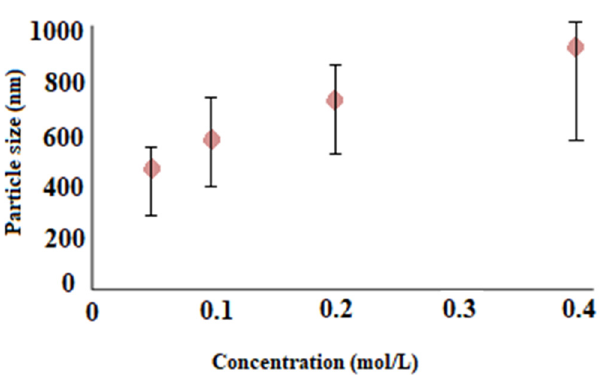
Figure 7. Variation in particle size depending on the initial concentration (800 °C, 1.0 L/min H 2 flow and 1.3 MHz).